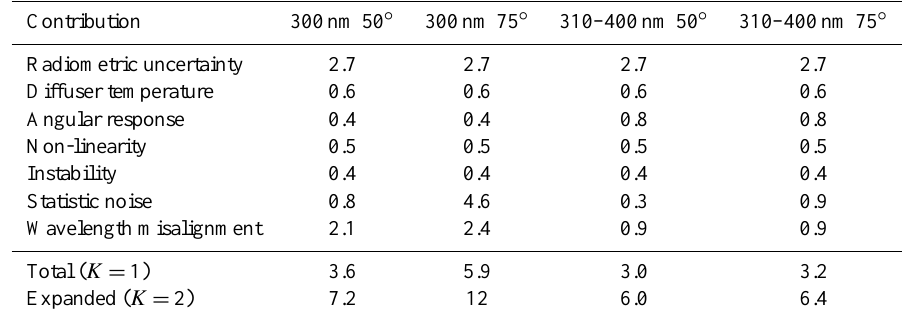
Table 4. Total uncertainty (%) of the spectroradiometer. The total radiometer uncertainty is calculated as the squared sum of the different